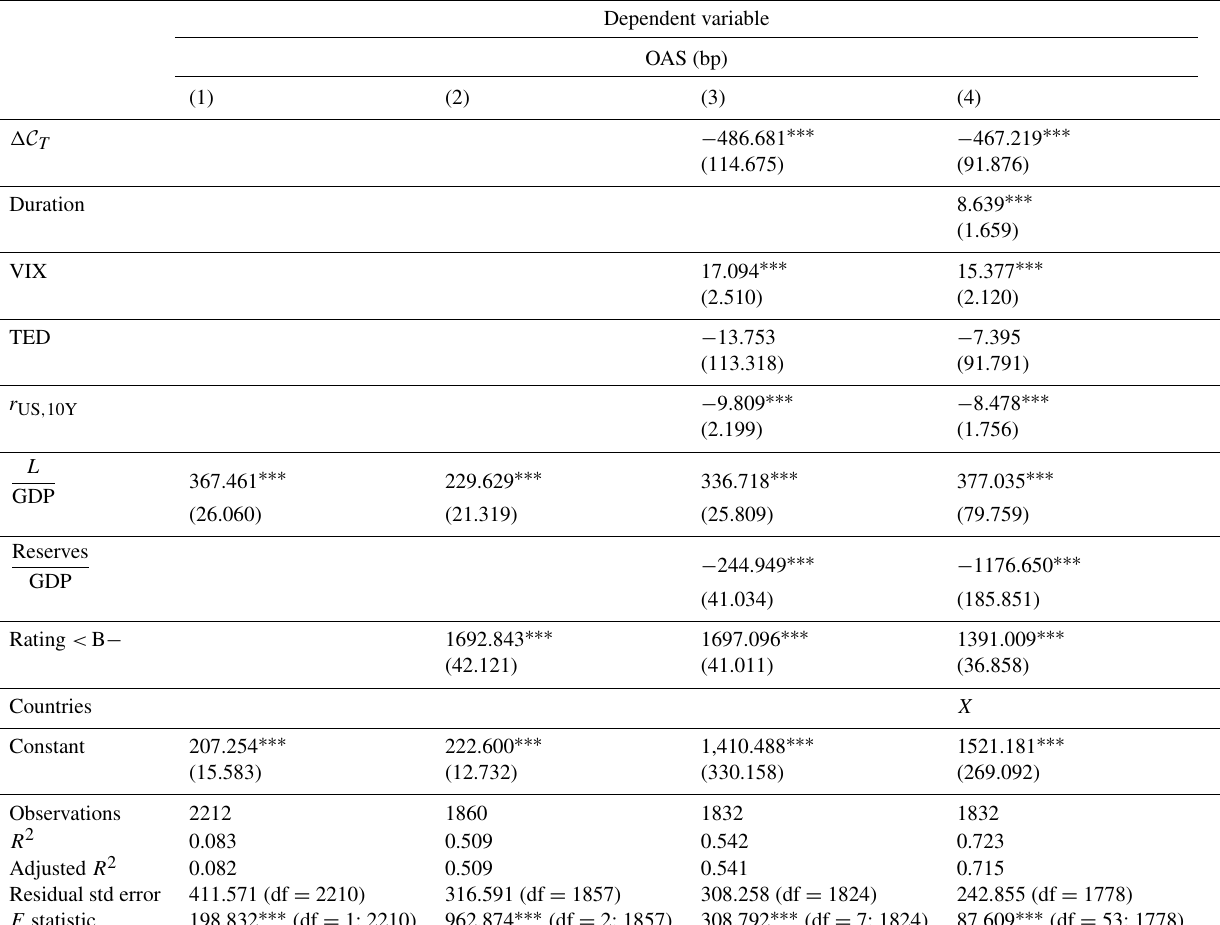
Table A7. Simple credit spread